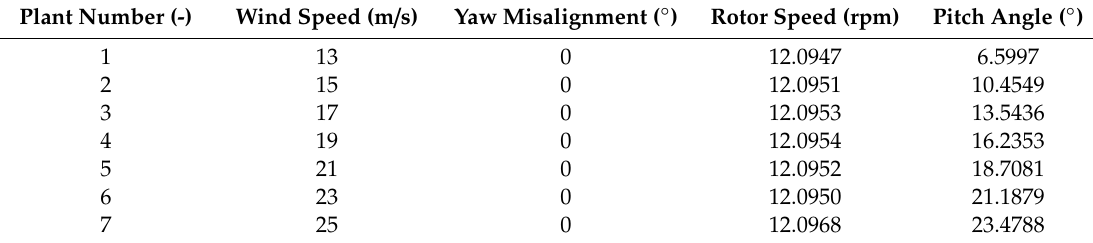
Table 1. Operating conditions of the performed linearization processes . Plant Number